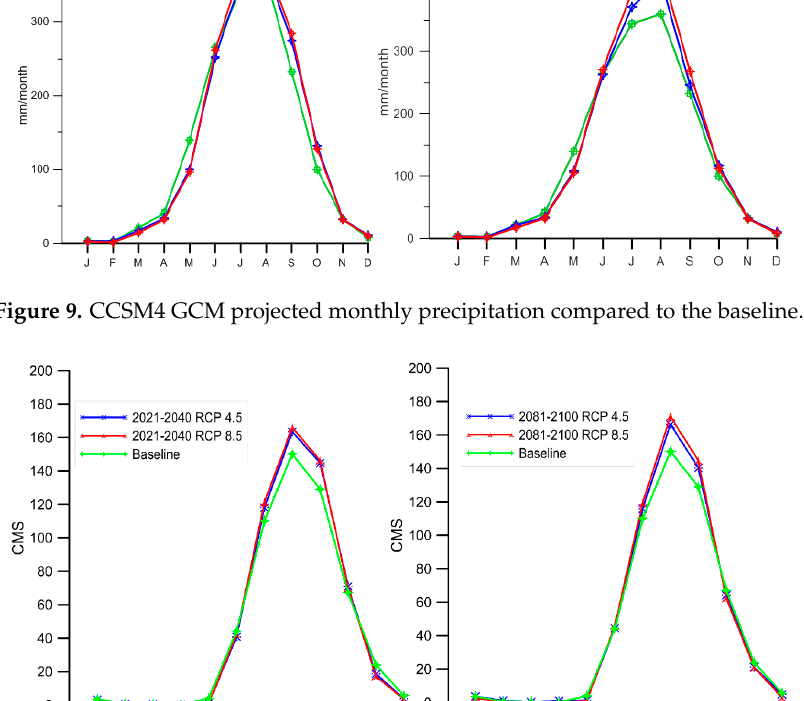
Figure 10. CCSM4 GCM projected monthly flow in cubic meter per second compared to the baseline.